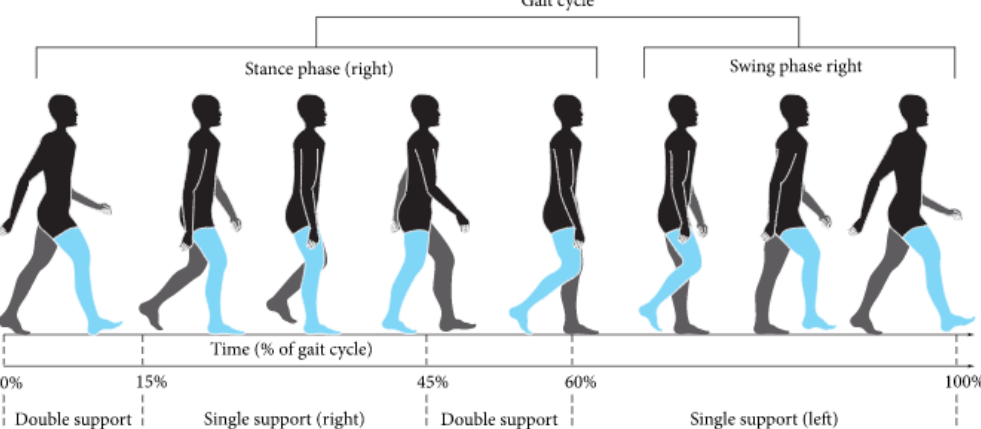
Figure 4. An illustration of gait phases (reprinted with permission from ref. [25]. Copyright 2019 Mariem Abid et al.) .